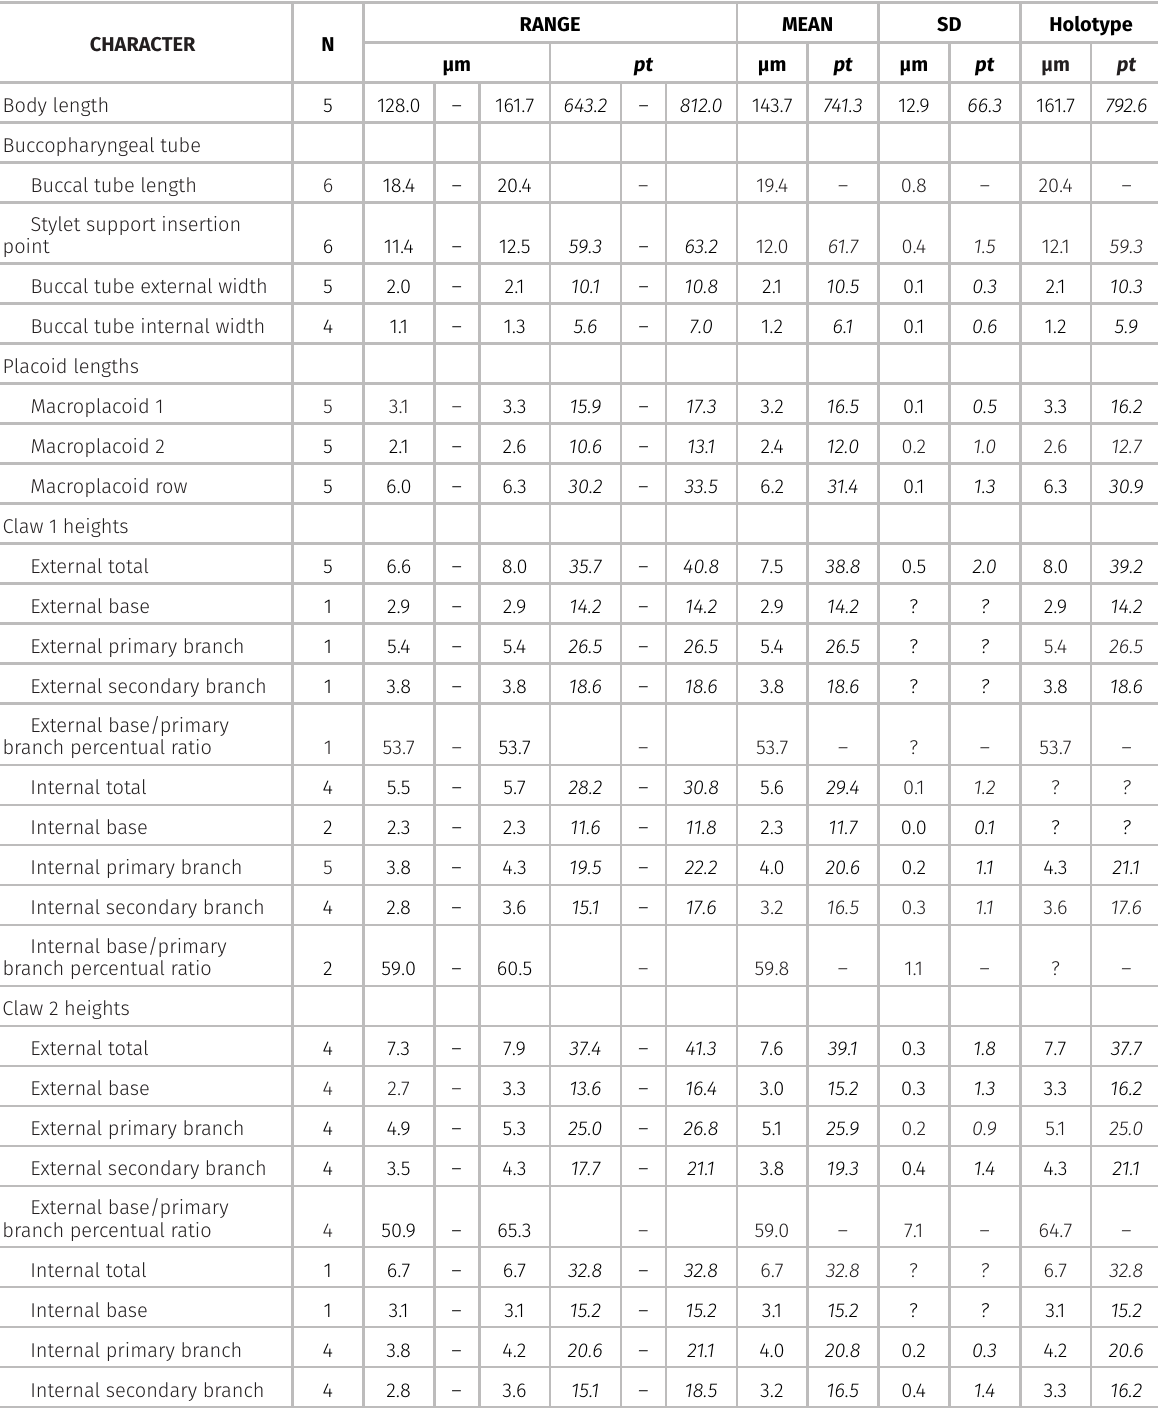
Table III. Morphometric analysis of the holotype and paratypes of Mixibius gibbosus sp. nov .; for correct comparison with some past species descriptions, also the entire length of claws is indicated; pt values are in italics (the pt index is the ratio of the length of a given structure to the length of the buccal tube, expressed as a percentage (Pilato 1981)); N = number of specimens measured for the given morphometric character. SD = standard